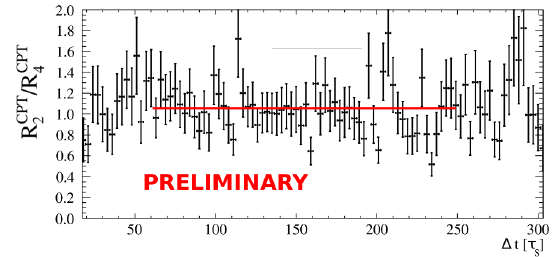
Figure 2. Preliminary distribution of the CPT-asymmetric double ratio obtained with the KLOE data. Points are the KLOE data, while the red line is a fitted line to data